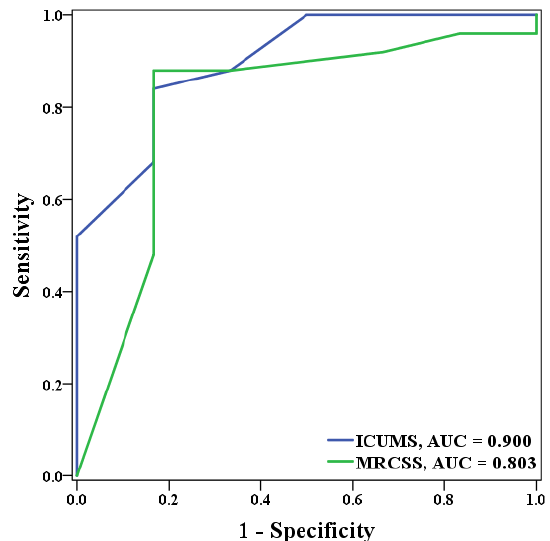
Figure 2. The ROC curve of ICUMS and MRCSS in predicting those with a Barthel index score of less than 100 at three months after discharge.